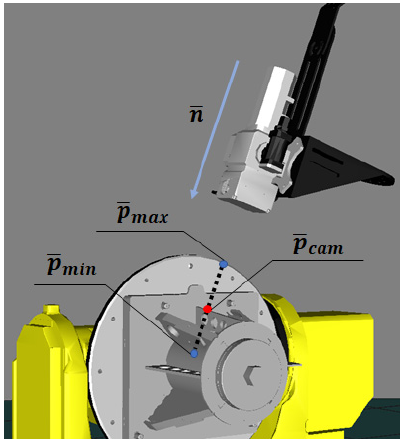
Figure 8. Scheme of tool movement in the process of automated detection of the focused position of the CCD camera.